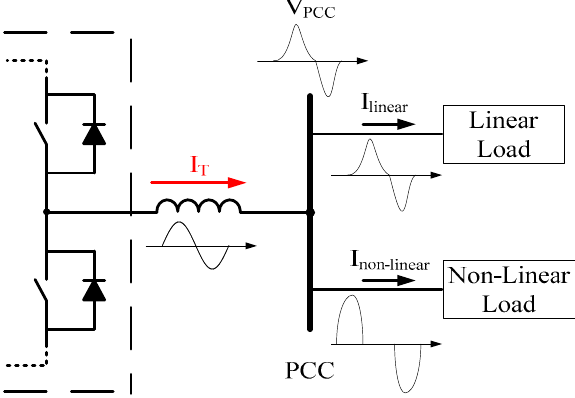
Figure 9. Current waveforms under the nonlinear load condition.